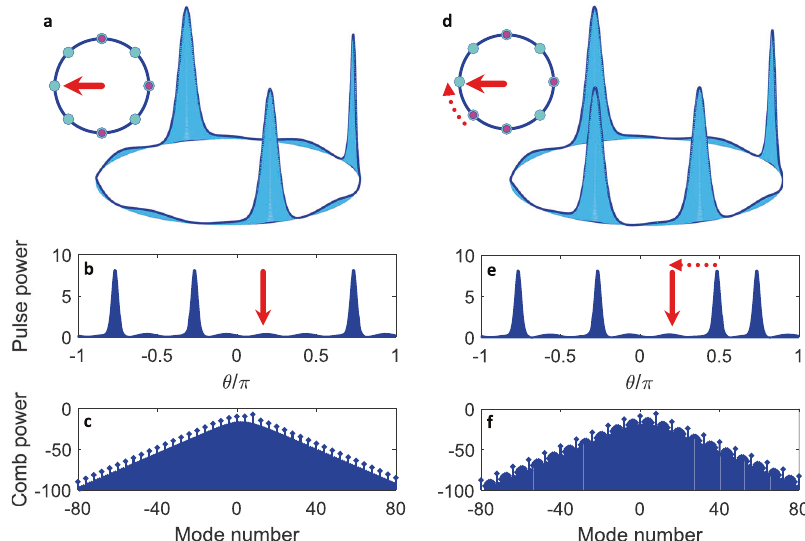
Fig. 5 Examples of DTCs carrying defects. A vacancy in which one soliton is missing from a period-doubling DTC a , and dislocation in which one soliton is misplaced by one lattice site d ; cf. Fig. 1b. The location of the missing or misplaced soliton (with respect to the perfect DTC) in each case is indicate by a red arrow in the top-view ring schematic (insets). b , e Snapshots of the optical pulse train per round-trip time, matching the top panels a and d , respectively, with red arrows hinting at the position of the missing or dislocated soliton. c , f Power spectra corresponding to b and e . Dotted arrows in d and e connect the current position of the dislocated soliton to its placement in the perfect crystal. Numerical parameters are the same as those in Fig. 3d –